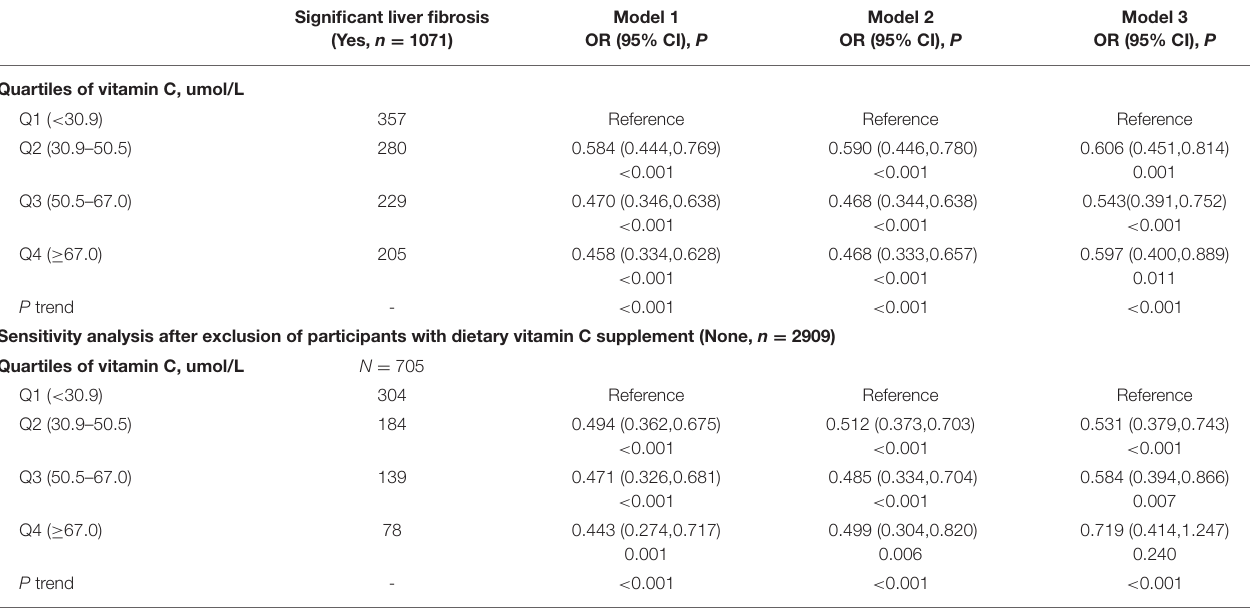
Model 1 OR (95% CI), P